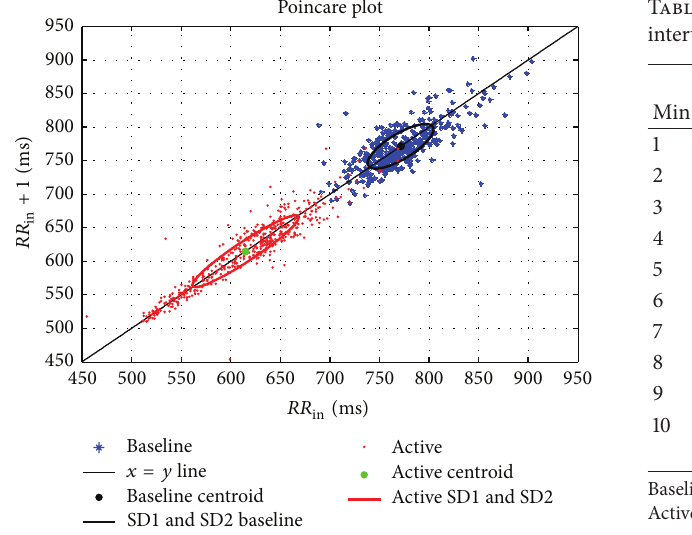
Figure 6: Poincare plot of 𝑅𝑅 intervals distribution.